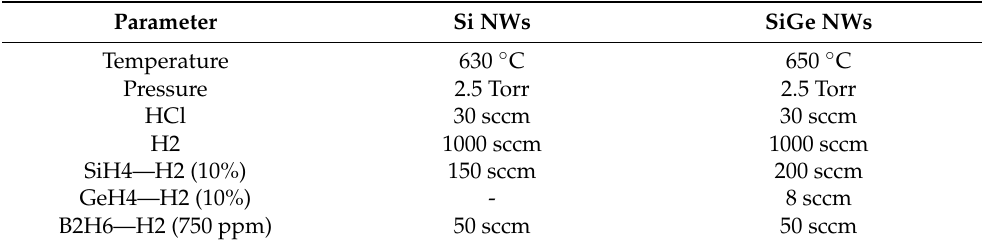
Table 1. VLS-CVD growth parameters for Si and SiGe NWs.